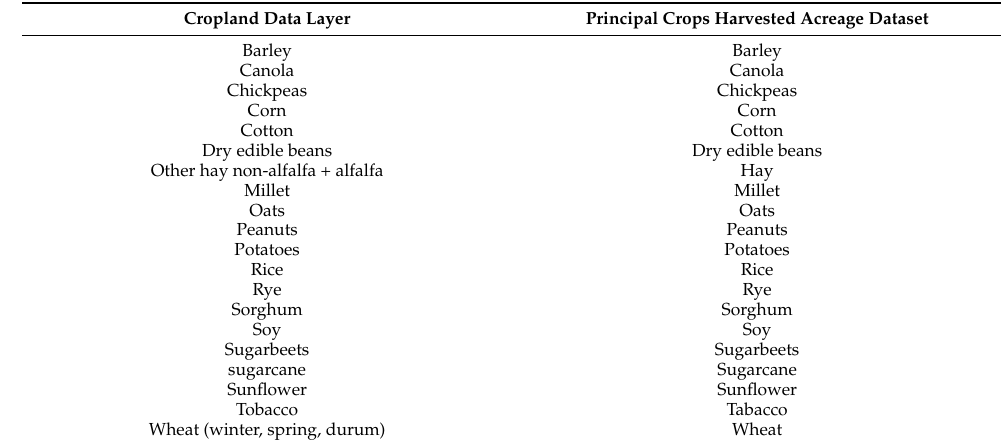
Table A1. Crop types or classes included in the Principal Crops Harvested Acreage dataset and in the Cropland Data Layer defined in this study.